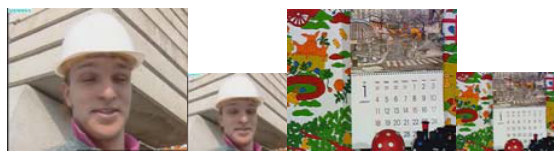
Fig.4. Key frames of “Foreman” and “Mobile” with different resolution (CIF and QCIF).